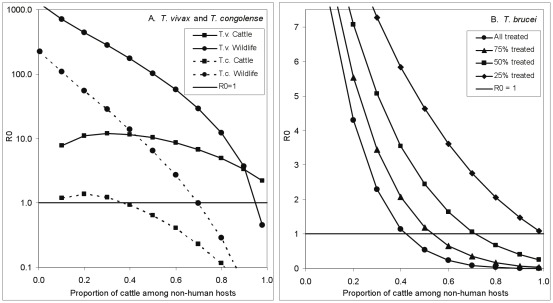
How the presence of wild hosts affects the control of T. brucei using insecticide.The relationship between the basic reproductive value, R
0, and the proportion of cattle among all non-human mammalian hosts in the situation where a proportion of cattle are treated with insecticide that kills any fly attempting to feed off that animal. A. T. vivax and T. congolense in cattle and wildlife - where all cattle are treated with insecticide. B. T. brucei; total R
0 in humans, cattle and wildlife for situations where different proportions of the cattle are treated with insecticide.